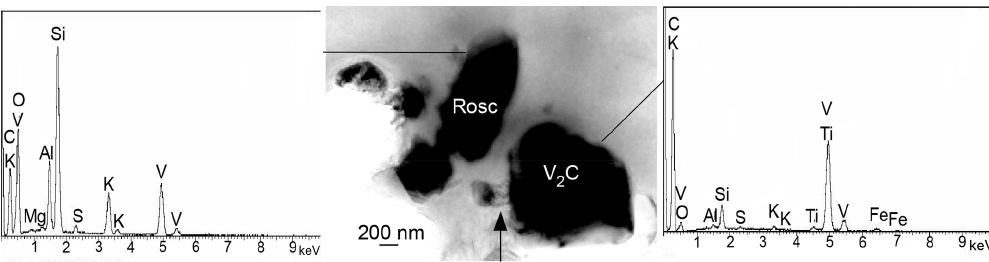
Figure 4. Paragenesis of vanadium carbide and roscoelite with corresponding EDS spectra in Sh1 samples. Three nano-sized regions with an increased vanadium content are indicated by an